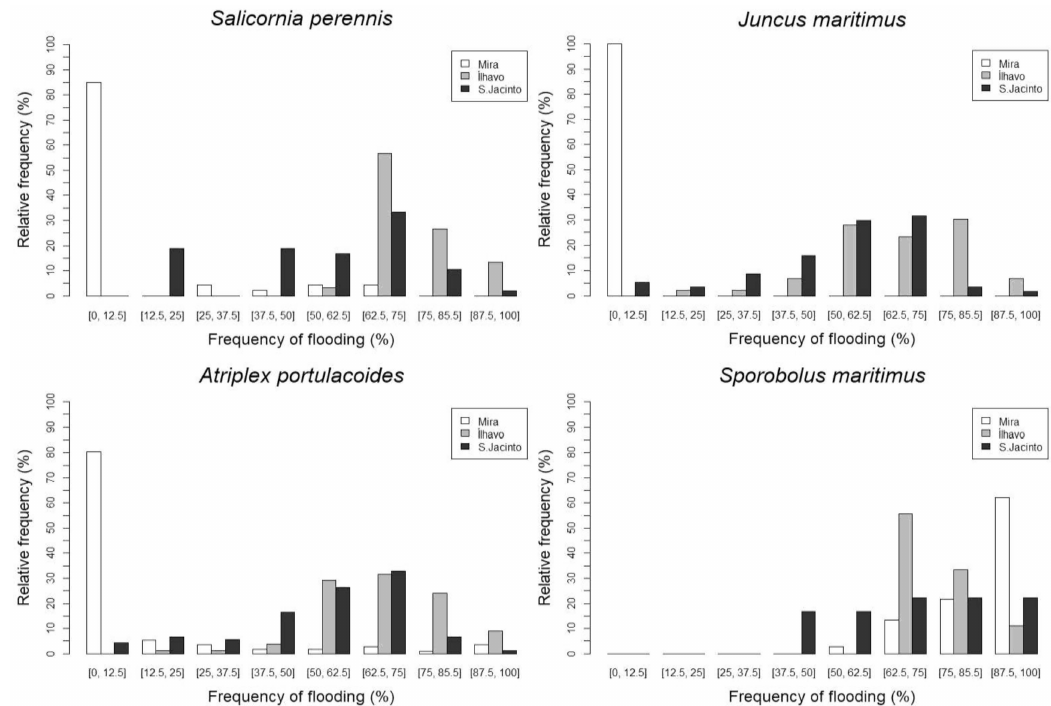
Figure A6. Frequency of flooding (F (%)). Relative frequency distribution of the main species regarding the frequency of flooding percentage for each of the studied